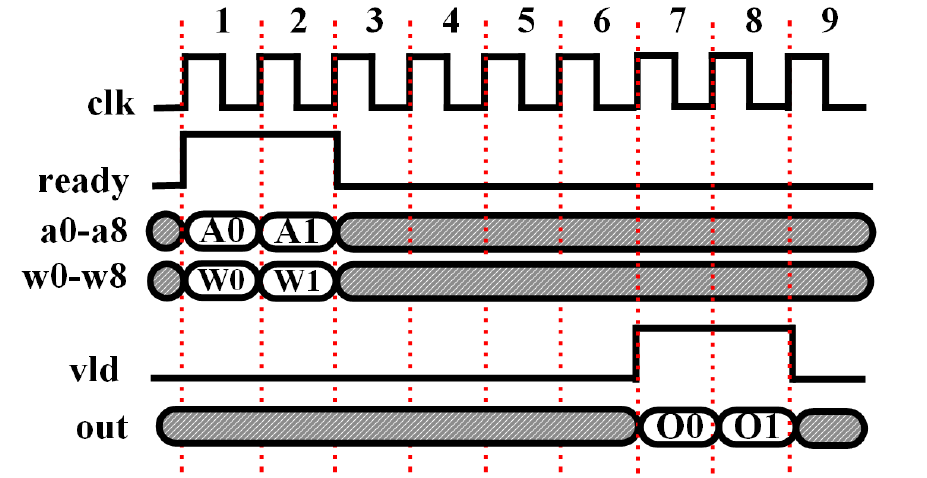
Figure 7. Timing diagram of streaming design of a convolutional layer